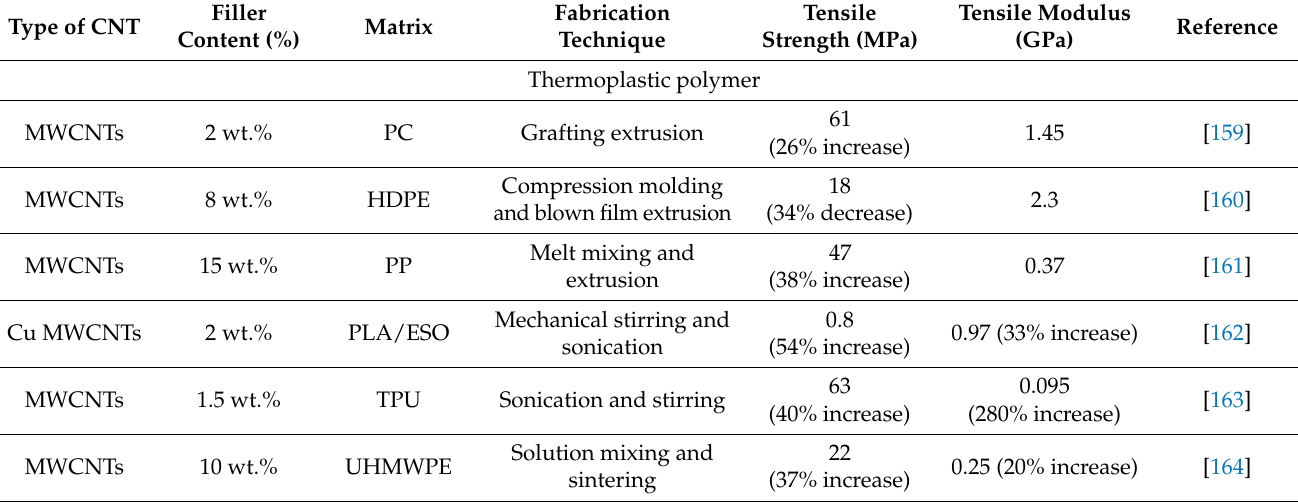
Table 7. Summary of the mechanical properties of CNT–polymer composites from 2015 to